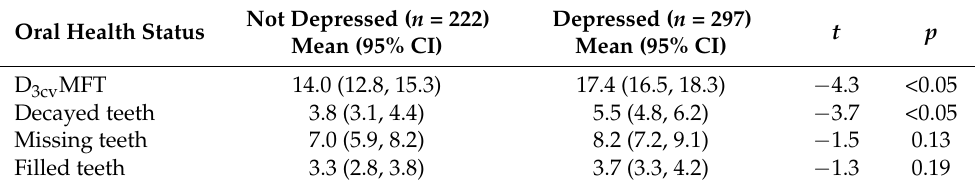
Table 5. Comparison of obvious decay experience with depression.